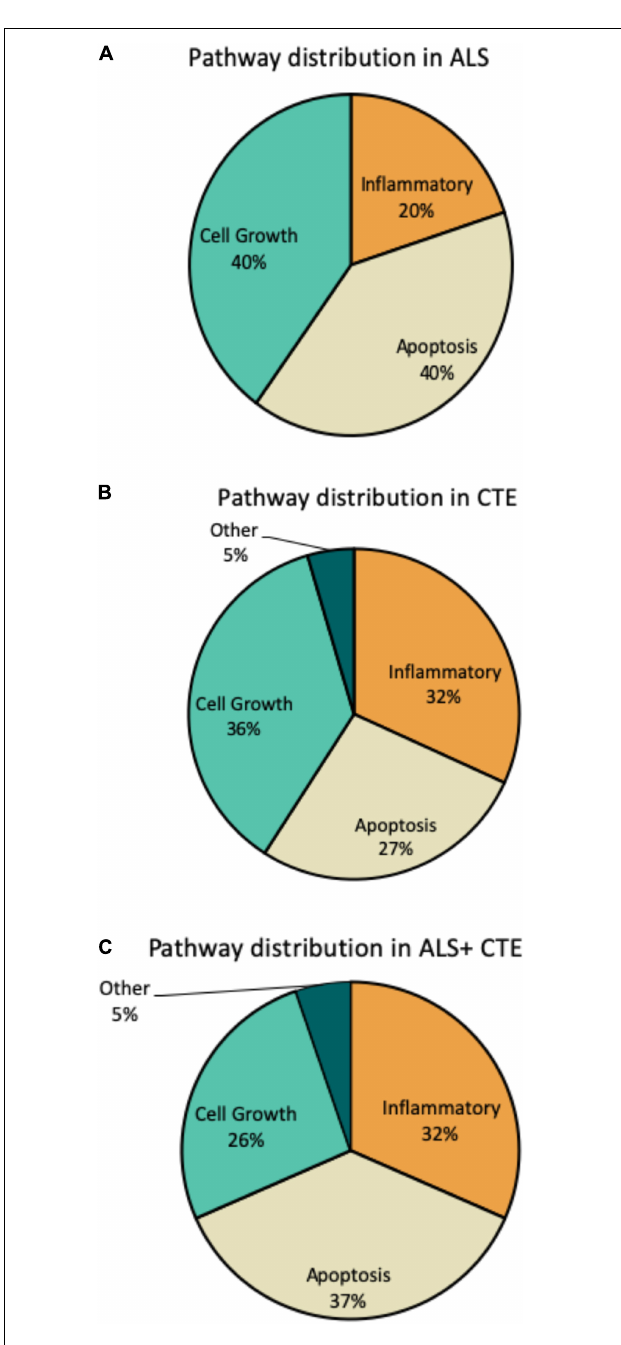
FIGURE 5 | Frequency of miRNA pathways in disease. MiRNAs were classified into inflammatory, cell growth, apoptotic, and other pathways and the frequency within each pathway is shown. (A) . Frequency of miRNA pathways in ALS. (B) . Frequency of miRNA pathways in CTE. (C) . Frequency of miRNA pathways in CTE +